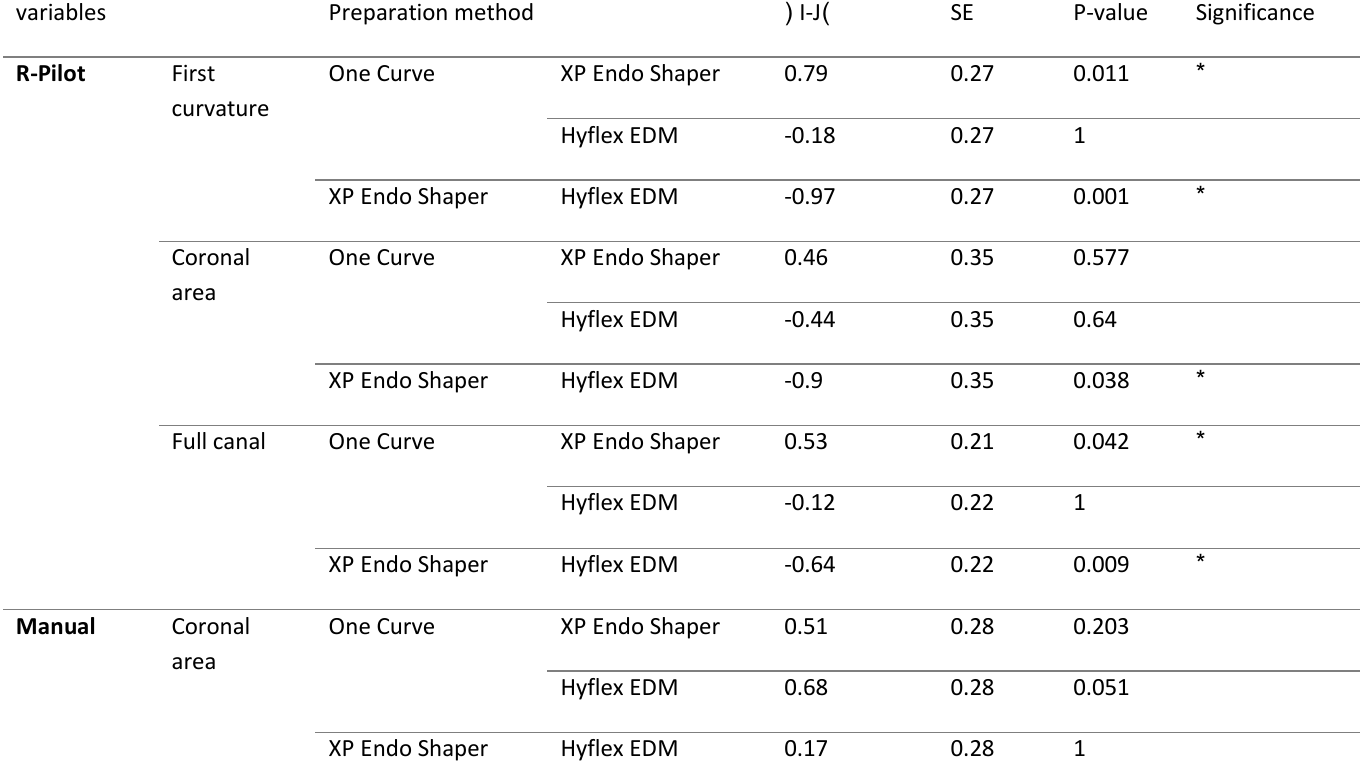
Table 3: Studying the deviation from the canal centric after preparation, Bonferroni test